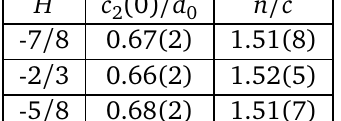
Table 9: Cylinder limit c central charge c , obtained from fit (37), for surfaces (52).